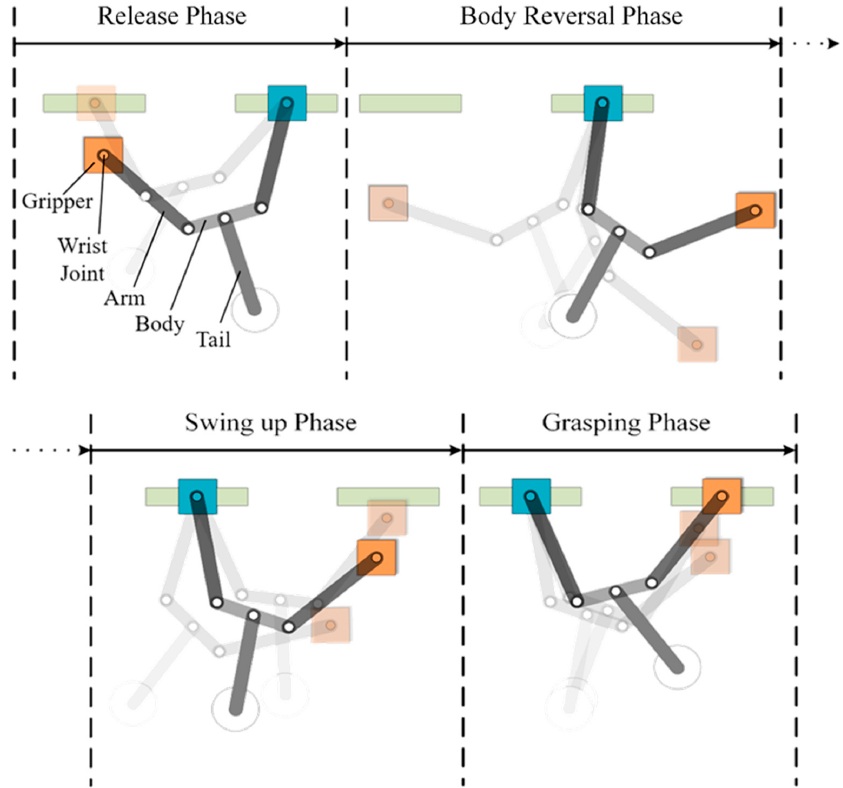
Figure 2. Schematic diagram showing proposed brachiation locomotion